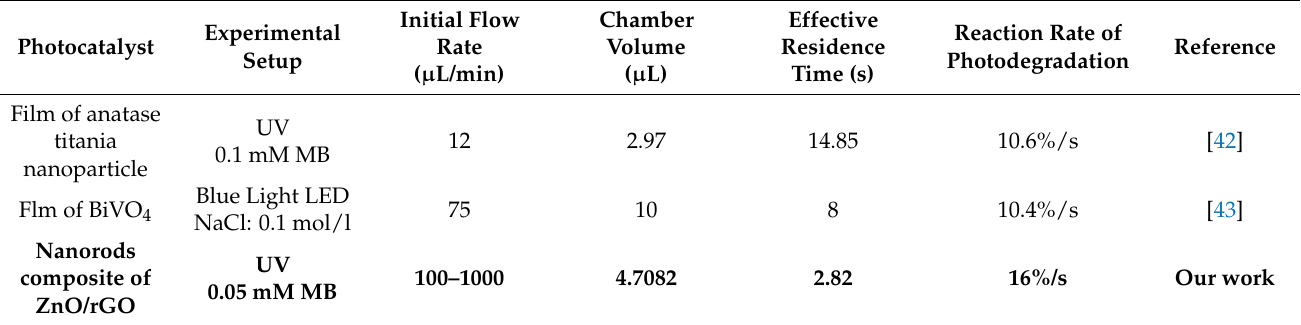
Table 7. Comparison of recent studies of photocatalytic degradation in microfluidic systems with our